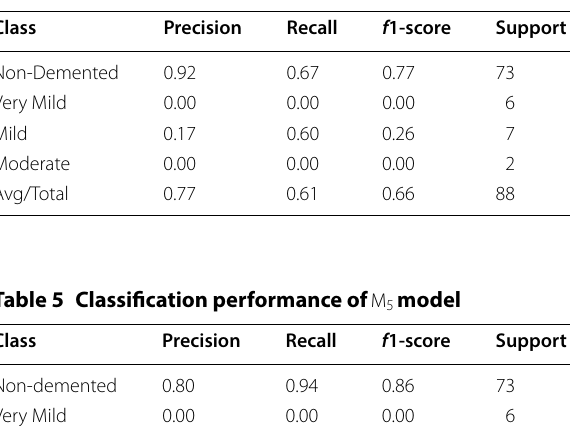
Table 4 Classification performance of M 4 model